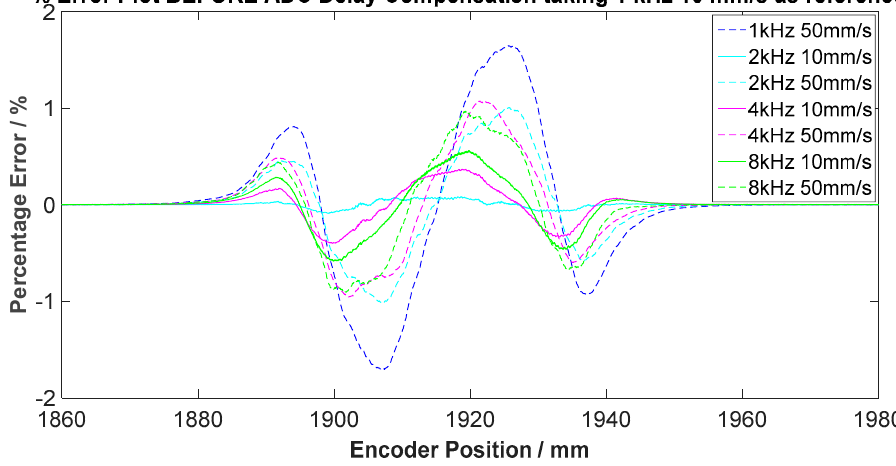
Figure 10. The response of the instrument output when traversing the magnet array with a Mexican hat shaped magnetic field with peak values of 0.3 and − 0.55 T.